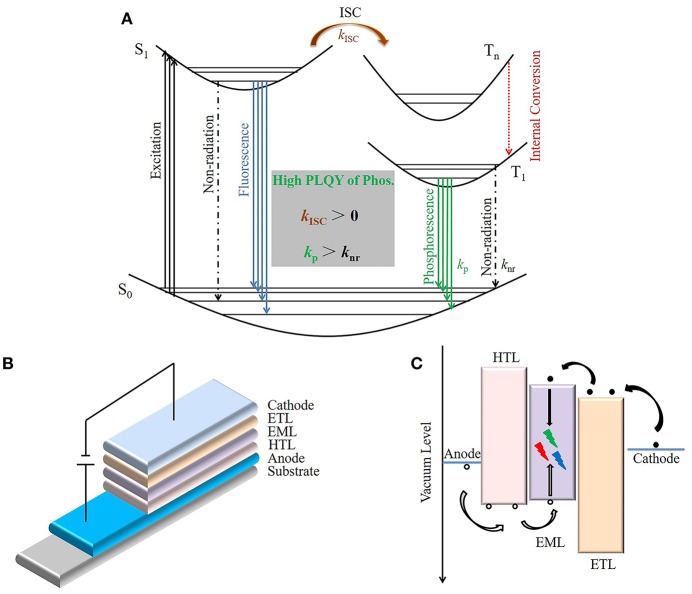
Schematic diagram of OLEDs based on RTP materials. (A) Schematic Jablonski diagram of photoluminescence for RTP materials. (B) The typical structure of three-layer OLEDs. (C) The schematic injection, transport, and recombination process of holes (black circles) and electrons (black dots) in OLEDs.